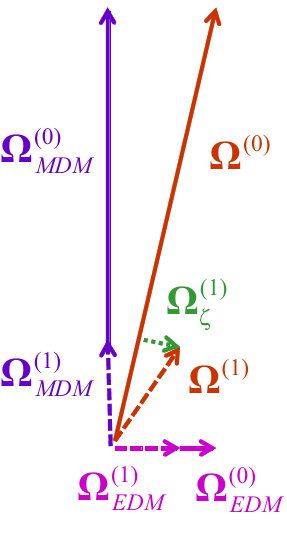
Fig. 2 Electric-field flipper. The resonance effect takes place and is ( 1 ) defined by the vector (cid:4)